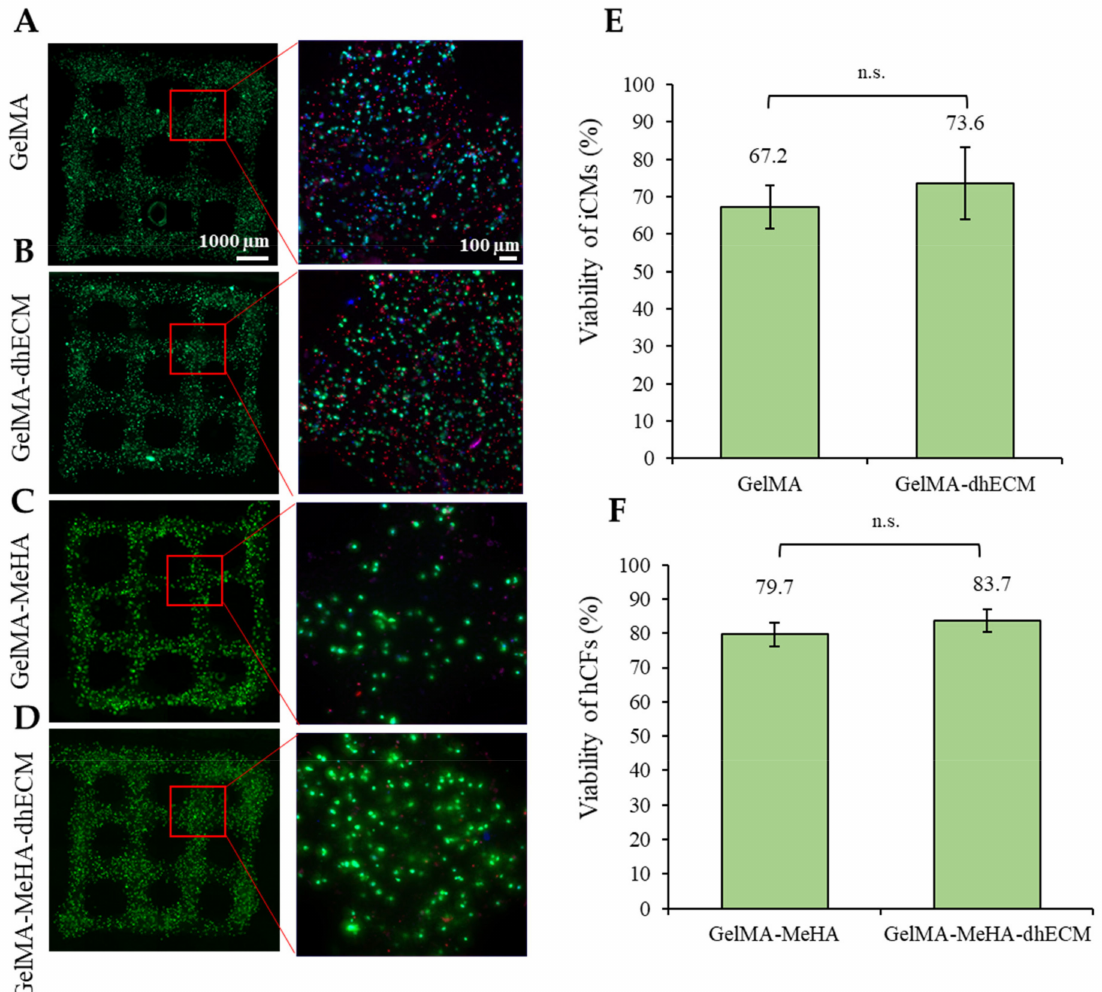
Figure 5. Cell viability analysis of the printed cell-laden hydrogels prepared using ( A ) GelMA, ( B ) GelMA–dhECM, ( C ) GelMA–MeHA, ( D ) GelMA–MeHA–dhECM, ( E ) live cell percentage comparison for GelMA and GelMA–dhECM, ( F ) live cell percentage comparison GelMA–MeHA and GelMA–MeHA–dhECM (n.s.: not significant) (Student’s t -test) ( n ≥